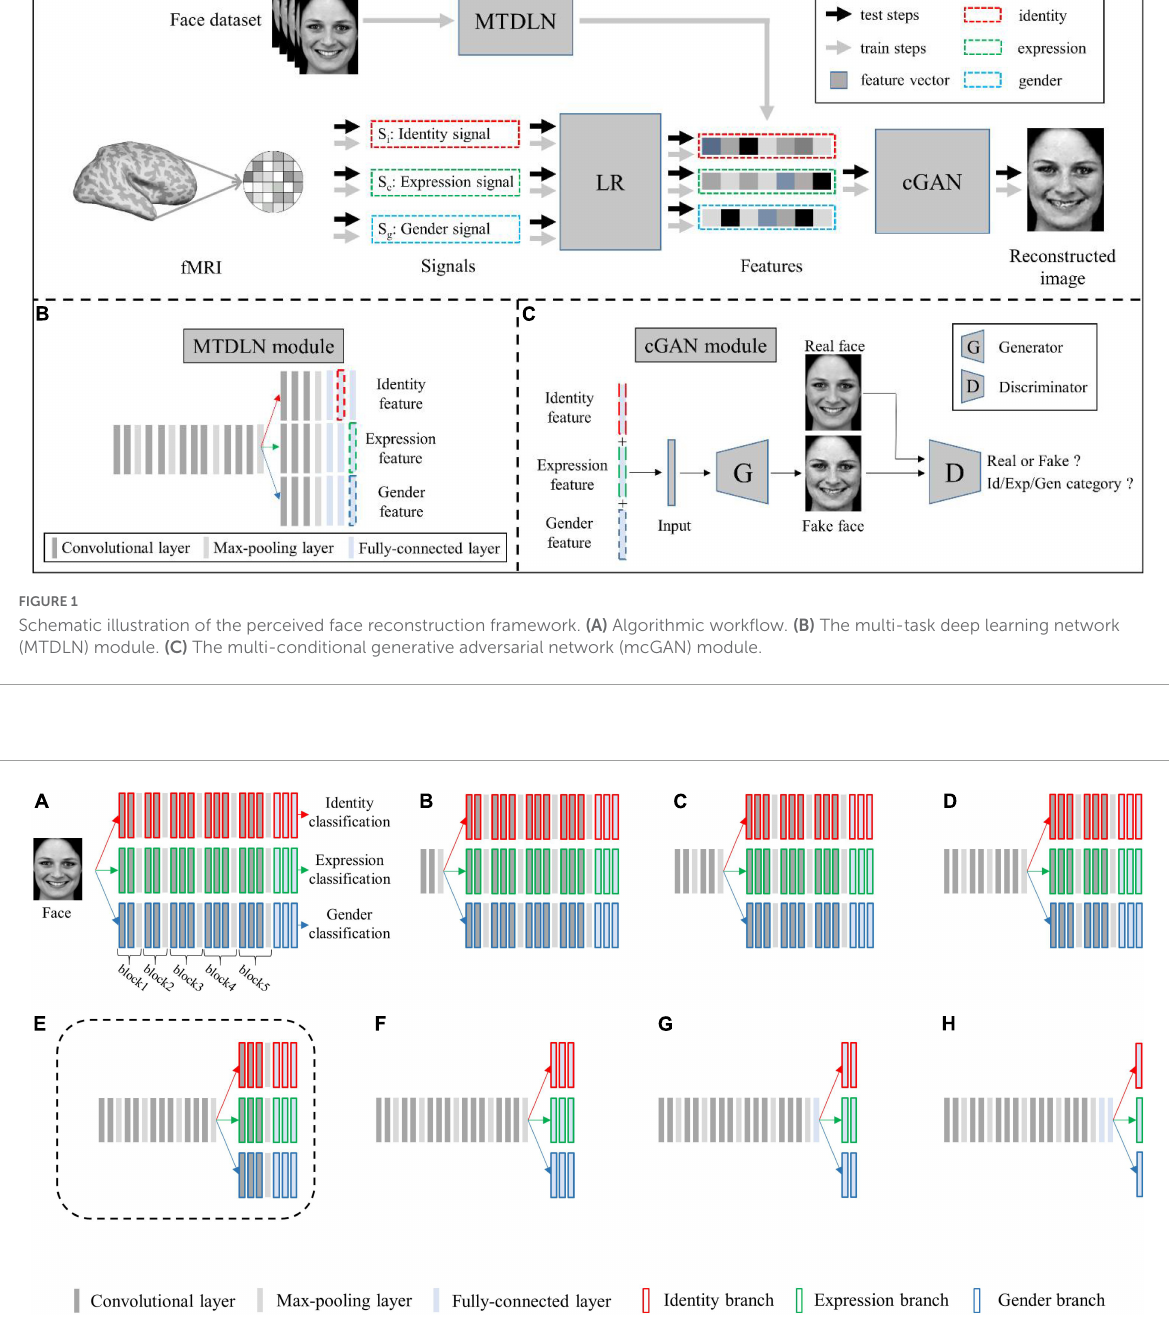
FIGURE2 Schematic diagram of eight candidate multi-task network architectures for simultaneously classifying facial expression, identity, and gender. The architectures vary at which layer the network is split into three branches, sharing no layers (A) , one block (B) , two blocks (C) , three blocks (D) , four blocks (E) , five blocks (F) , five blocks and one fully-connected layer (G) , and five blocks and two fully connected layers (H) . Each bar represents one convolutional neural network (CNN) layer. Specifically, the bars with red borders represent layers in the identity branch, the bars with green borders represent layers in the expression branch, and the bars with blue borders represent layers in the gender branch. The architecture (E) surrounded by a dashed line is the best-performing